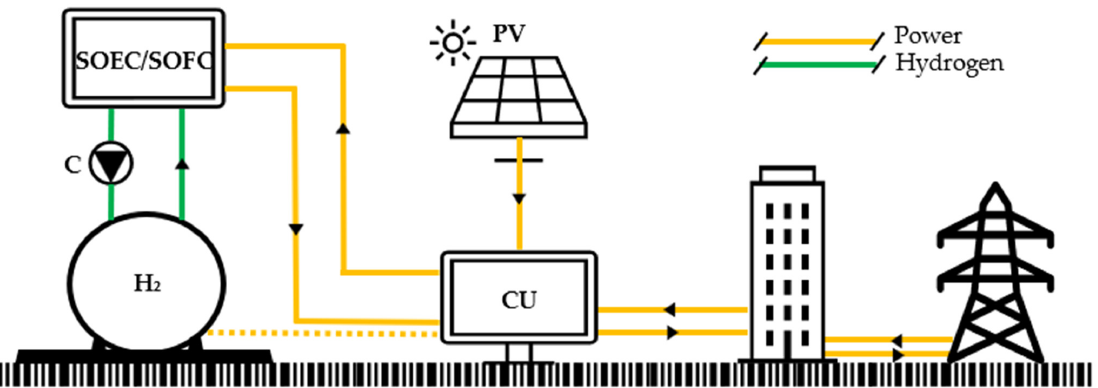
Figure 3. Layout of the system.